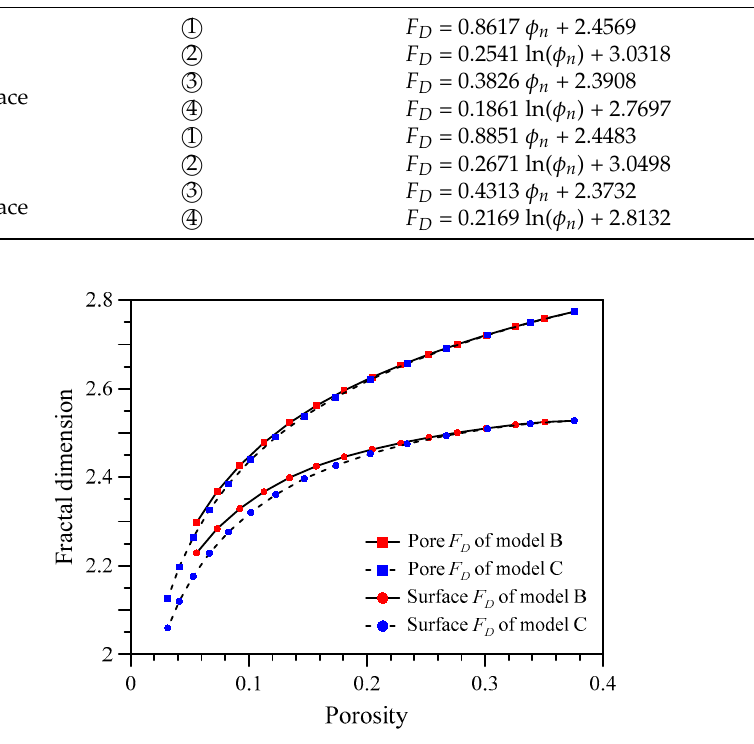
Figure 10. The comparison of fractal dimensions between compaction model and cementation model.